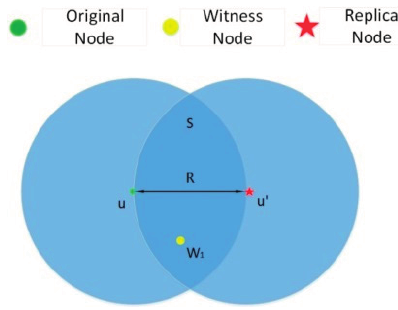
Figure 1. An example of detecting a replication attack by using